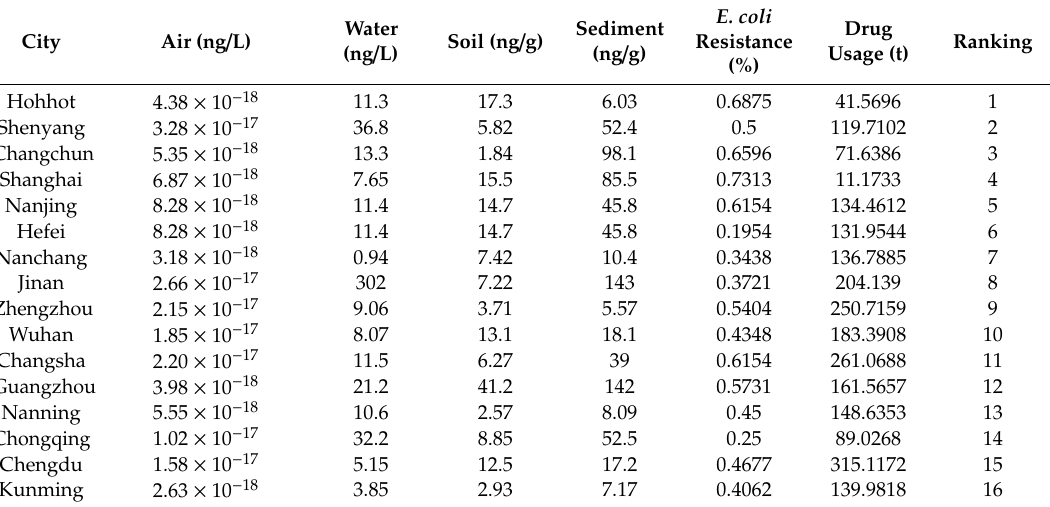
Table 6. E. coli doxycycline resistance index in major cities in